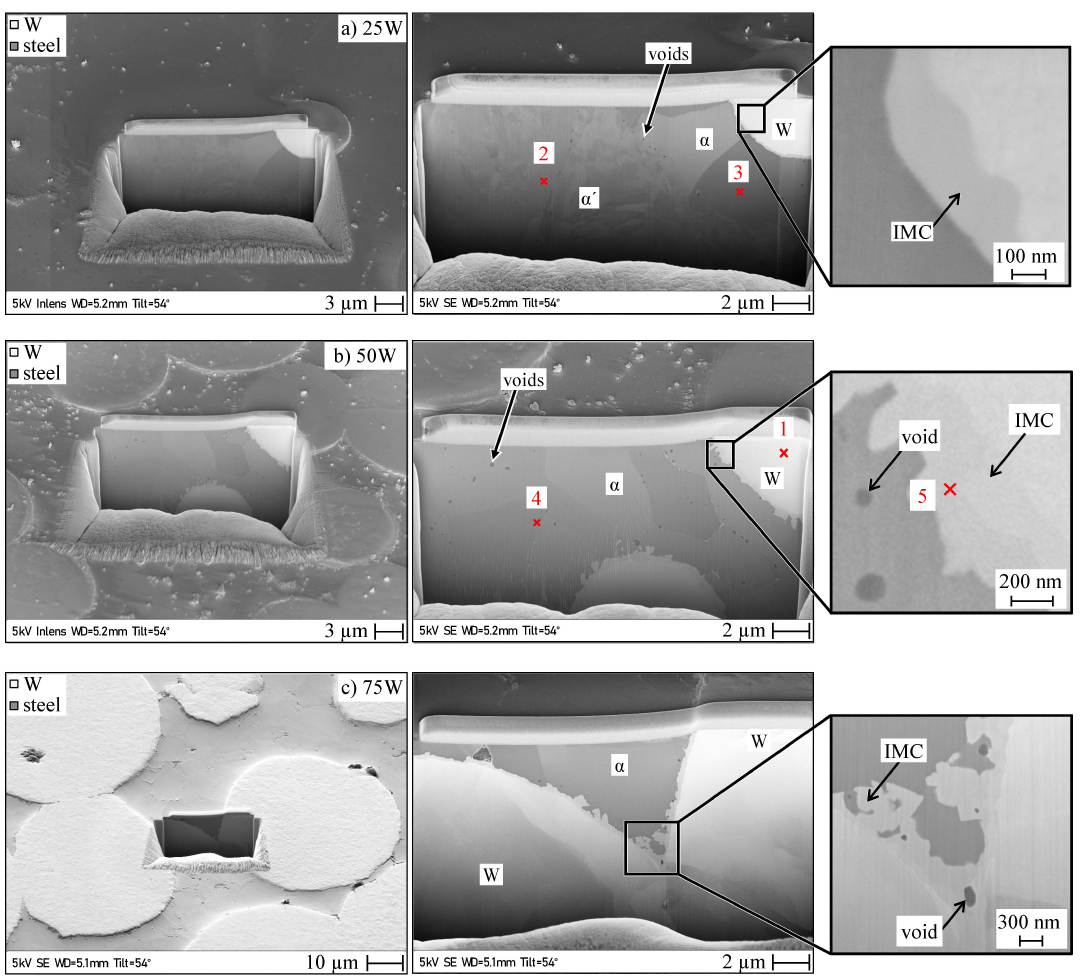
Figure 7. Comprehensive SEM micrographs showing individual phases: ( a ) 25 W; ( b ) 50 W; ( c ) 75